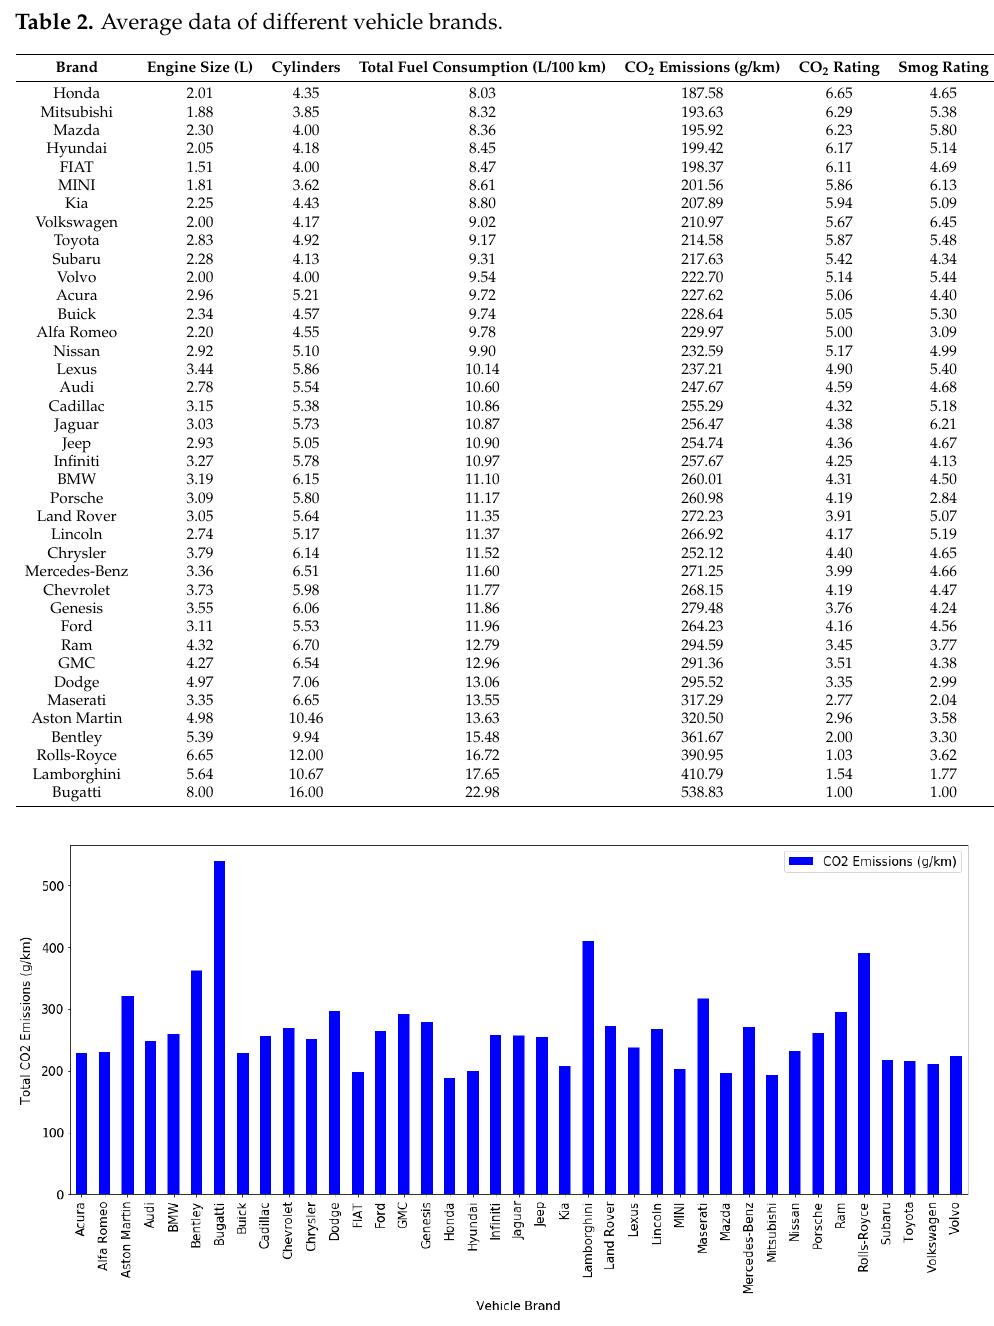
Figure 3. CO 2 emissions (g/km) of each